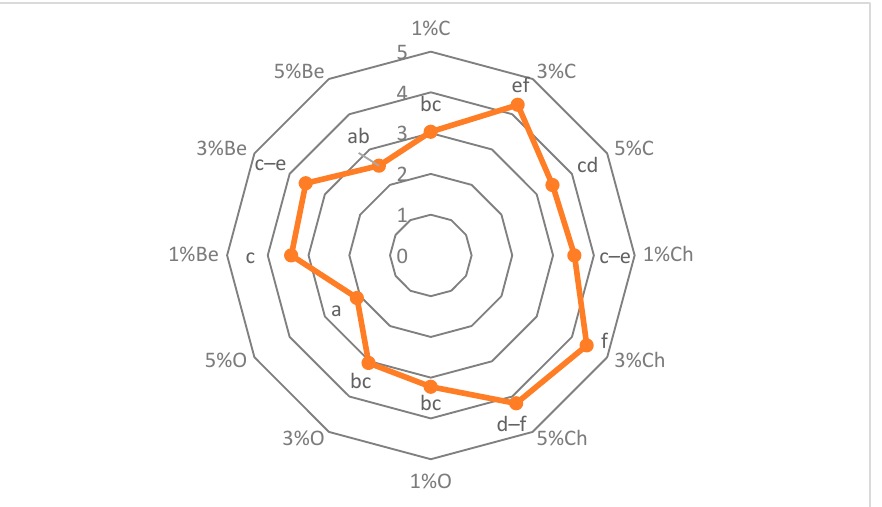
Figure 6. Organoleptic evaluation of fat-free dairy desserts enriched with different amounts (1, 3, or 5%) of dried vegetables (C—carrot; Ch—champignon; O—onion; Be—beetroot). (Scale: 1–5 points;